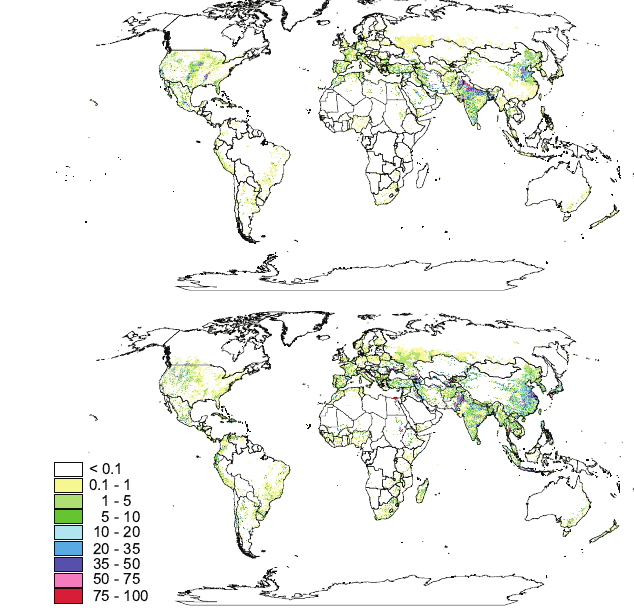
Fig. 3. Percentage of 5arcmin grid cell area equipped for irrigation with groundwater (top) and with surface water (bottom; see the electronic Supplement for a high resolution version of this